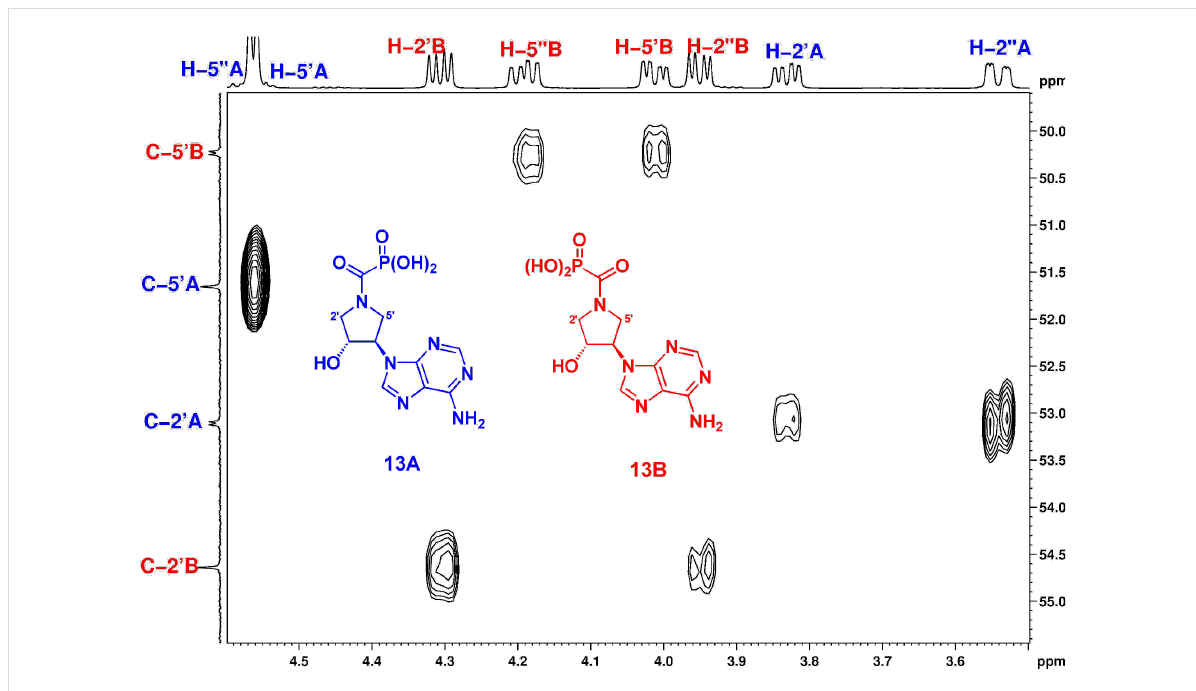
For the purposes of conformational analysis, it was necessary to assign correctly the NMR signals of the individual conformers.